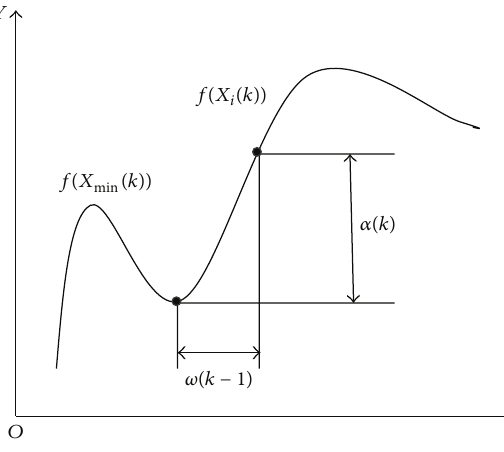
Figure 9: Dynamic adjustment method of inertia weight factor.